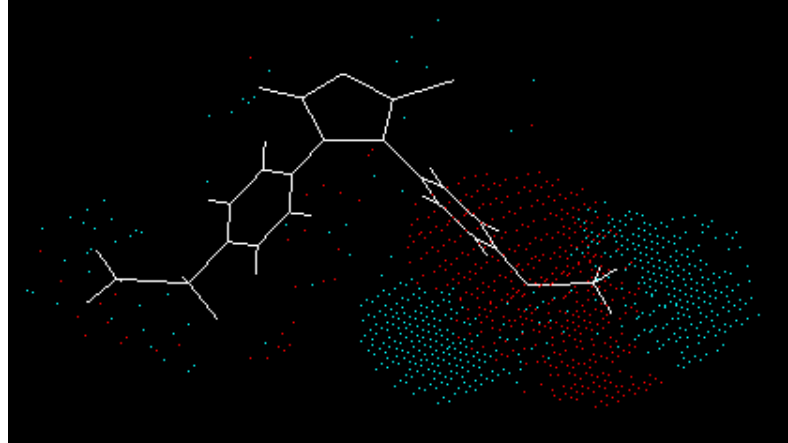
Figure 6. The shape master grid with compound 18. Red represents areas of favorable steric interaction. Blue represents areas of unfavorable steric